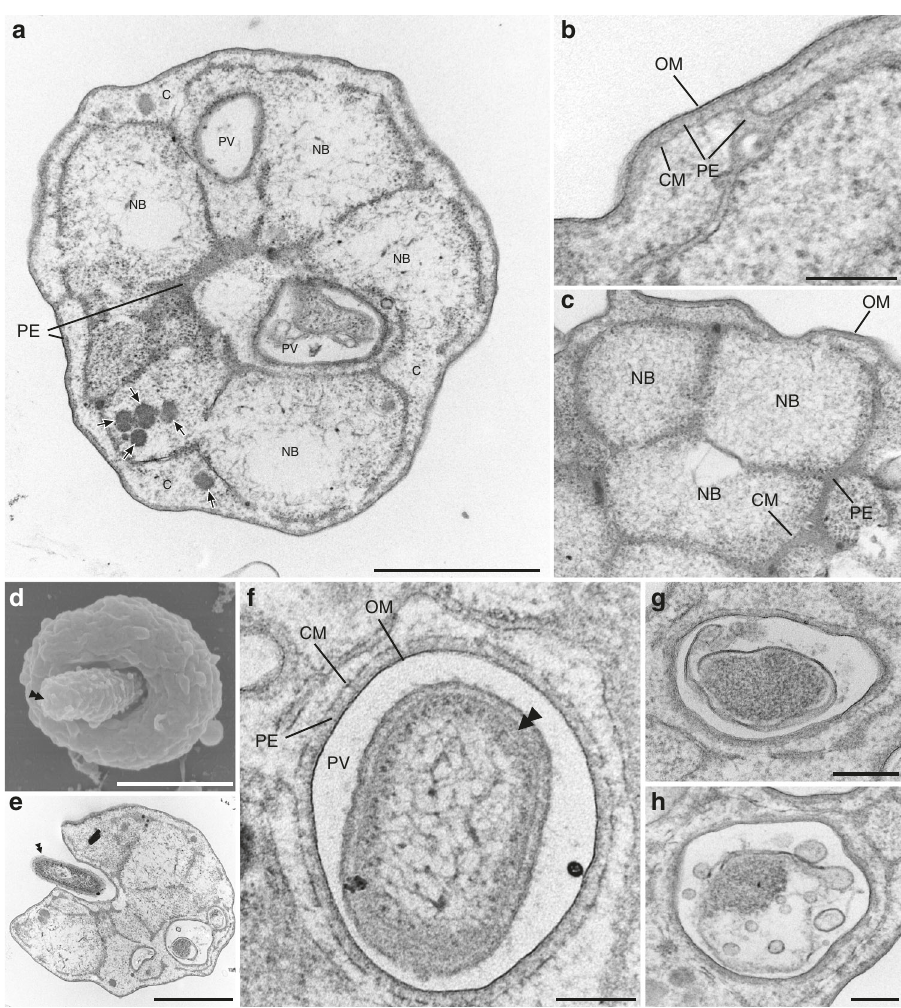
Fig. 3 Ultrastructure of ‘ Candidatus Uab amorphum ’ . a Transmission electron micrograph of ‘ Ca . Uab amorphum ’ showing cytoplasm (C), cytoplasmic membrane (CM), nuclear body (NB), outer membrane (OM), periplasm (PE) and phagosome-like vacuole (PV). Arrows indicate dense granules that are probably glycogen granules. b , c High-magni fi cation transmission electron micrograph showing the membrane structures. Cytoplasmic membrane (CM), nuclear body (NB), outer membrane (OM) and periplasm (PE). d Scanning electron micrograph of a ‘ Ca . Uab amorphum ’ that is about to engulf a prey bacterium (double arrowhead). e Transmission electron micrograph of a ‘ Ca . Uab amorphum ’ that is about to engulf a bacterium (double arrowhead). f Ultrastructure of PV that is surrounded by outer membrane (OM), periplasm (PE) and cytoplasmic membrane (CM). Double arrowhead indicates engulfed prey bacterium g , h that disrupted prey bacteria in PVs. Scale bars, 1 μ m ( a , d , e ), 500 nm ( b , h ) and 200 nm ( c , f , g